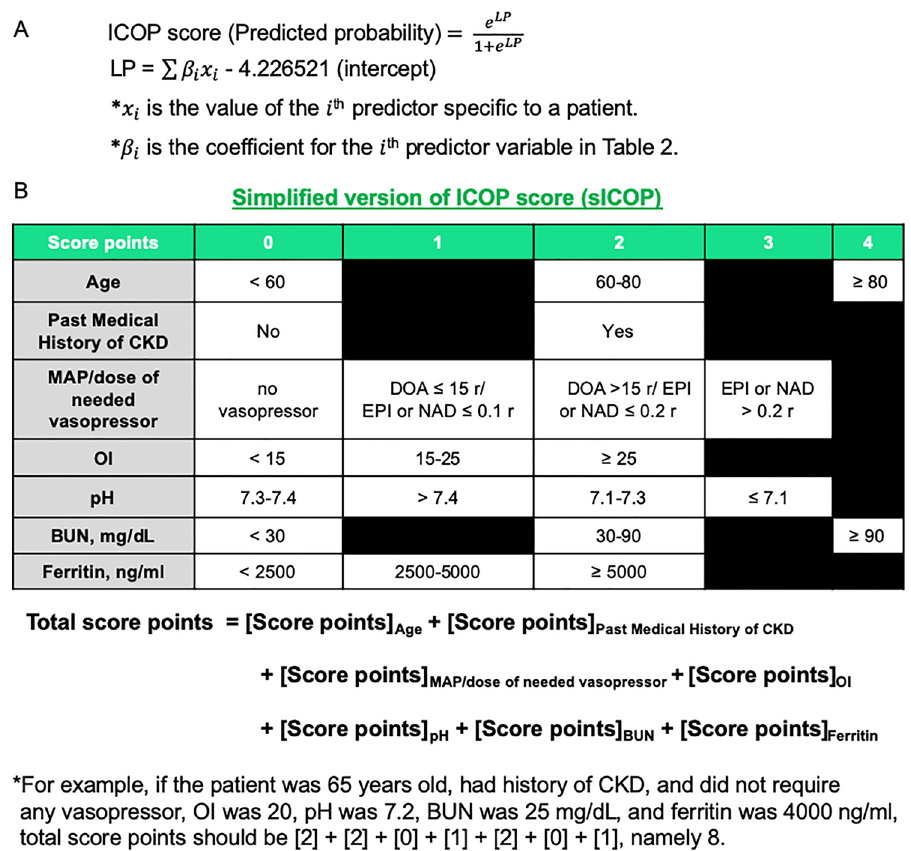
Figure 2. Formula of ICOP Score and sICOP. ( A ) The ICOP score is calculated as the predicted probability by using coefficient values in Table 2. ( B ) The formula of simplified version of ICOP (sICOP) score. The sICOP score was calculated by summing up each score points with the corresponding categorical variable. CKD , chronic kidney disease; MAP , mean arterial pressure; OI , oxygen index; BUN , blood urea